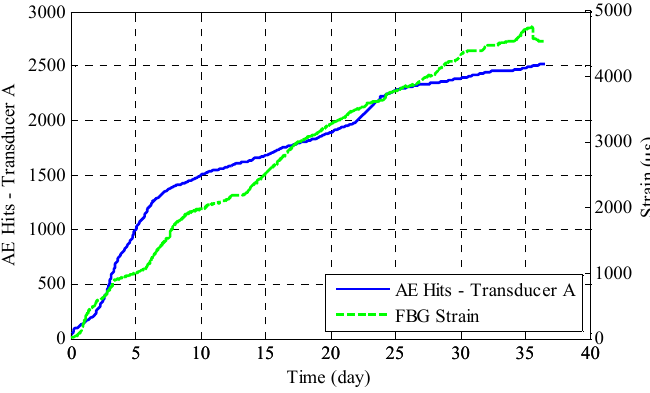
Figure 12. Simultaneous evaluation of acoustic emission activity and strain measurement.